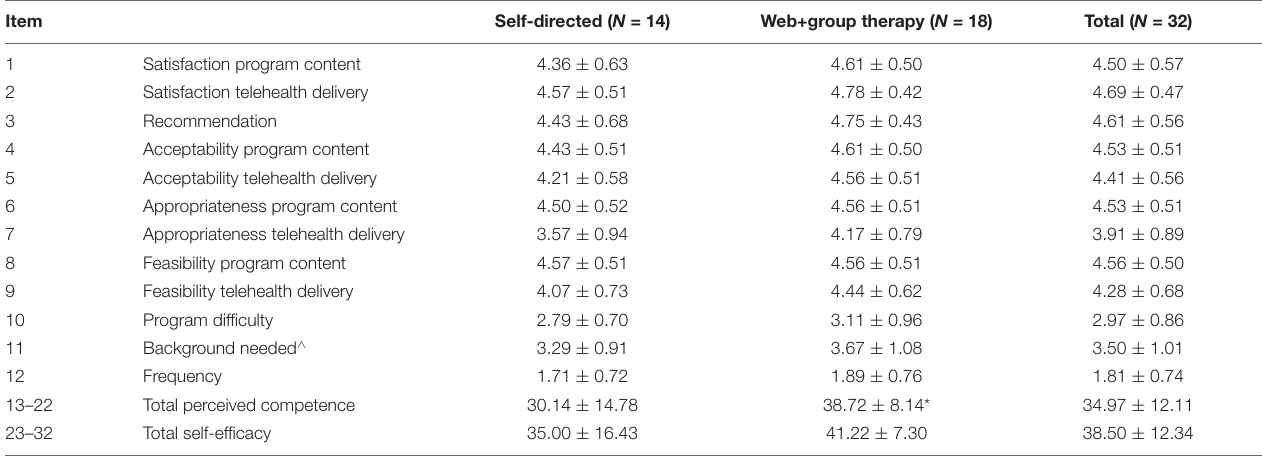
TABLE 5 | Average scores on program evaluation survey items between groups (Mean ±